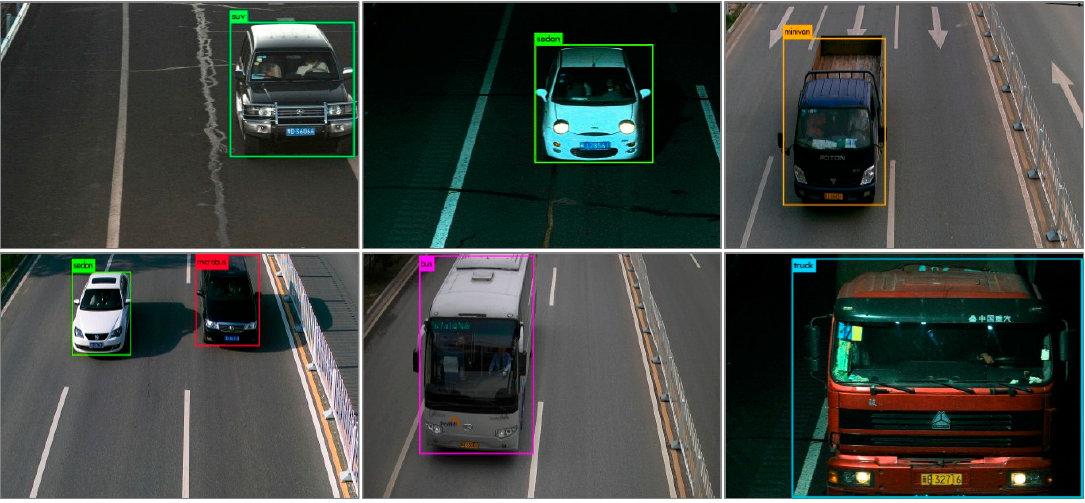
Figure 5. Examples of detection results.